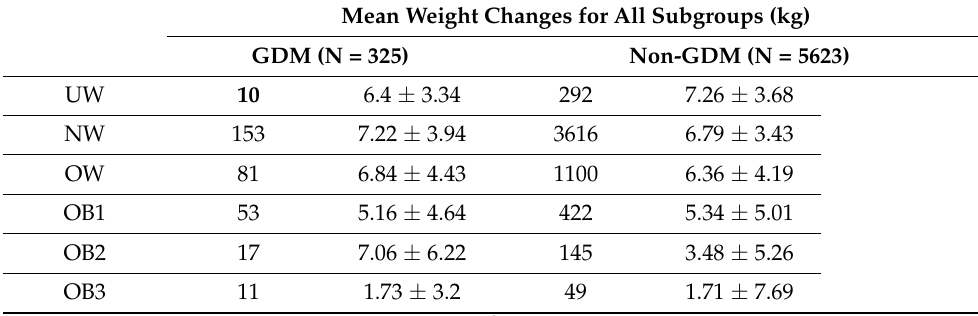
Table 3. Mean weight gain in all subgroups of the two groups. Mean Weight Changes for All Subgroups